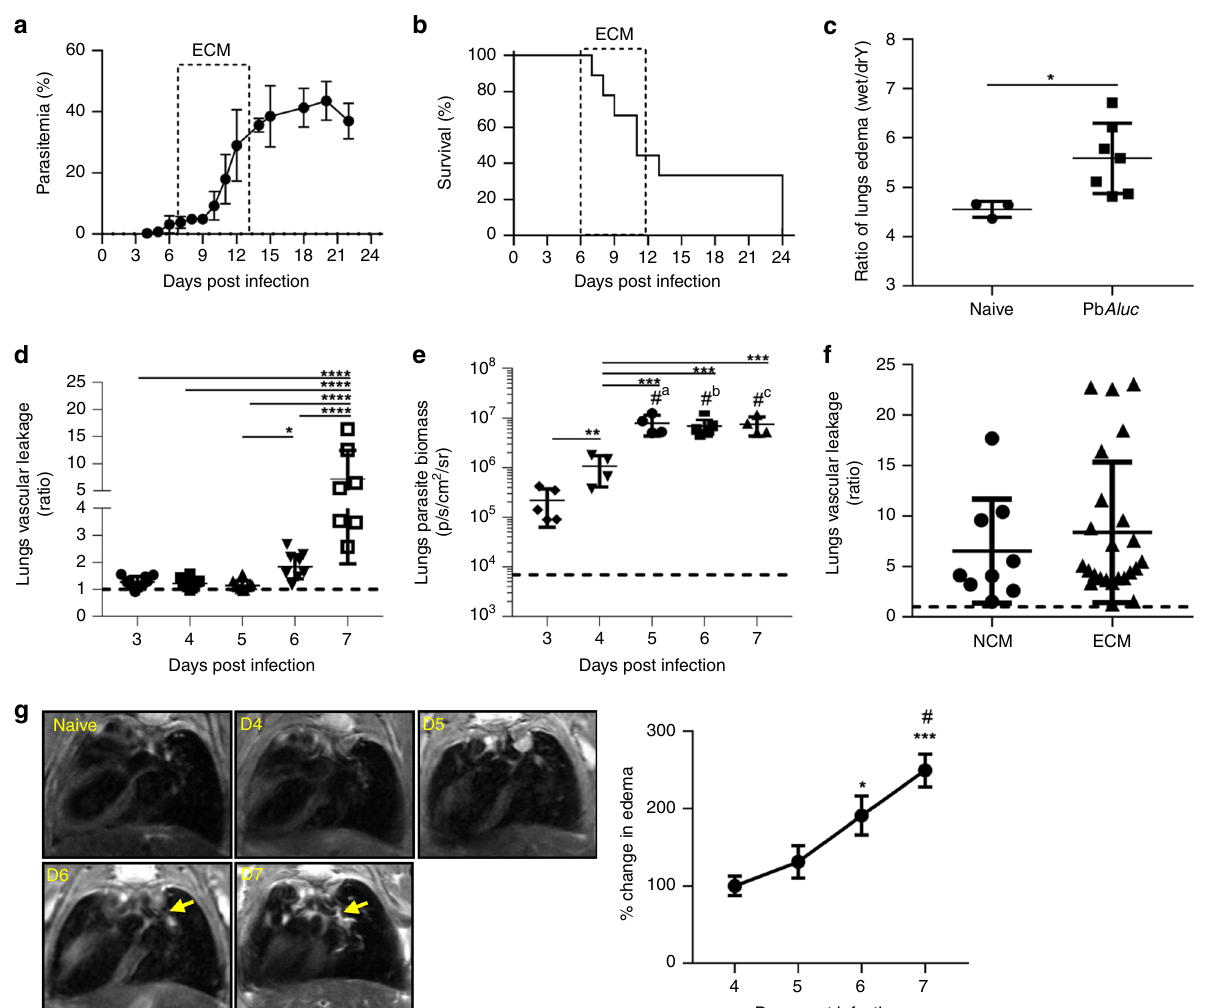
Fig. 1 Pathophysiological parameters measured in the lungs during PbA luc -infection in C57BL/6 mice. a Peripheral parasitemia levels and b survival curve of PbA luc -infected mice ( n = 9). The boxed area indicates the experimental cerebral malaria (ECM) phase. c Ratio of lung edema (wet-to-dry weight ratio) at 7 days post infection (dpi) in infected ( n = 7) and naive C57BL/6 ( n = 3) mice. d Ratio of in vivo lung vascular leakage measured by Tracer-653 dye at 3 – 7 dpi ( n = 10). e Ex vivo quanti fi cation of parasite biomass in the lungs based on luciferase activity of luciferase-tagged parasite after perfusion at 3 ( n = 5) 4 ( n = 4), 5 ( n = 4), 6 ( n = 5) and 7 dpi ( n = 4). The data shown are representative of two independent experiments. f Ratio of in vivo lung vascular leakage assessed in mice with non-cerebral malaria (NCM) ( n = 9) and with experimental cerebral malaria (ECM) ( n = 24). The black dashed line at y = 1 in ( d – f ) represents the ratio of the tracer reading from naive C57BL/6 mice ( n = 3). g MRI images of naïve C57BL/6 ( n = 4) and PbA luc -infected mice ( n = 5) taken consecutively from 4 – 7 dpi. Yellow arrows show edema (left hand side images). Edema quanti fi cation based on manual segmentation/ volume calculation (right hand side graph). The data represent the mean ± SD; * p < 0.05 by Mann – Whitney test ( c ); * p < 0.05, ** p < 0.01, *** p < 0.001, **** p < 0.0001 by ANOVA with Bonferroni ’ s post-test ( d – e , g ). Figure e , “ # ” represents statistical signi fi cance compared to 3 dpi; a,b,c p < 0.0001; Figure g , represents statistical signi fi cance compared to 4 dpi ( p < 0.05); “ # ” represents statistical signi fi cance compared to 5 dpi (*** p <